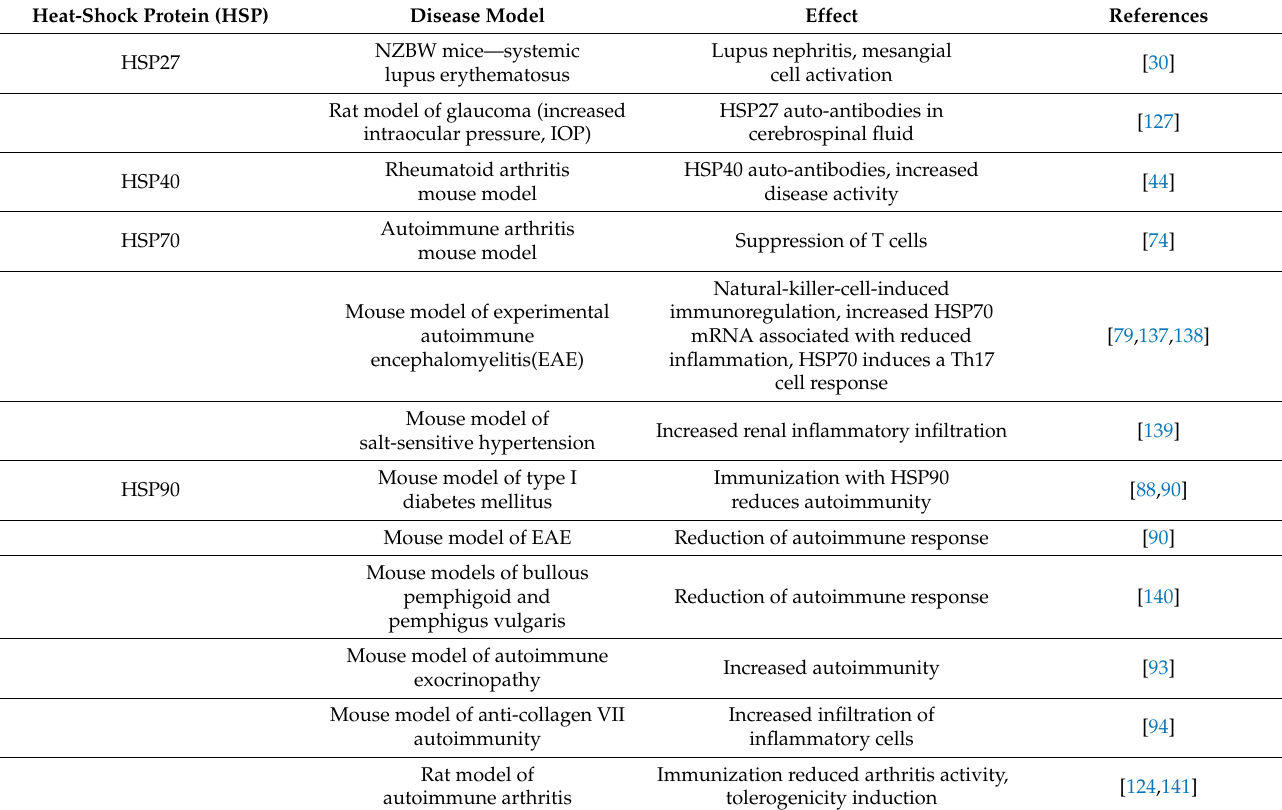
Table 2. Autoimmune effects of heat-shock proteins in animal